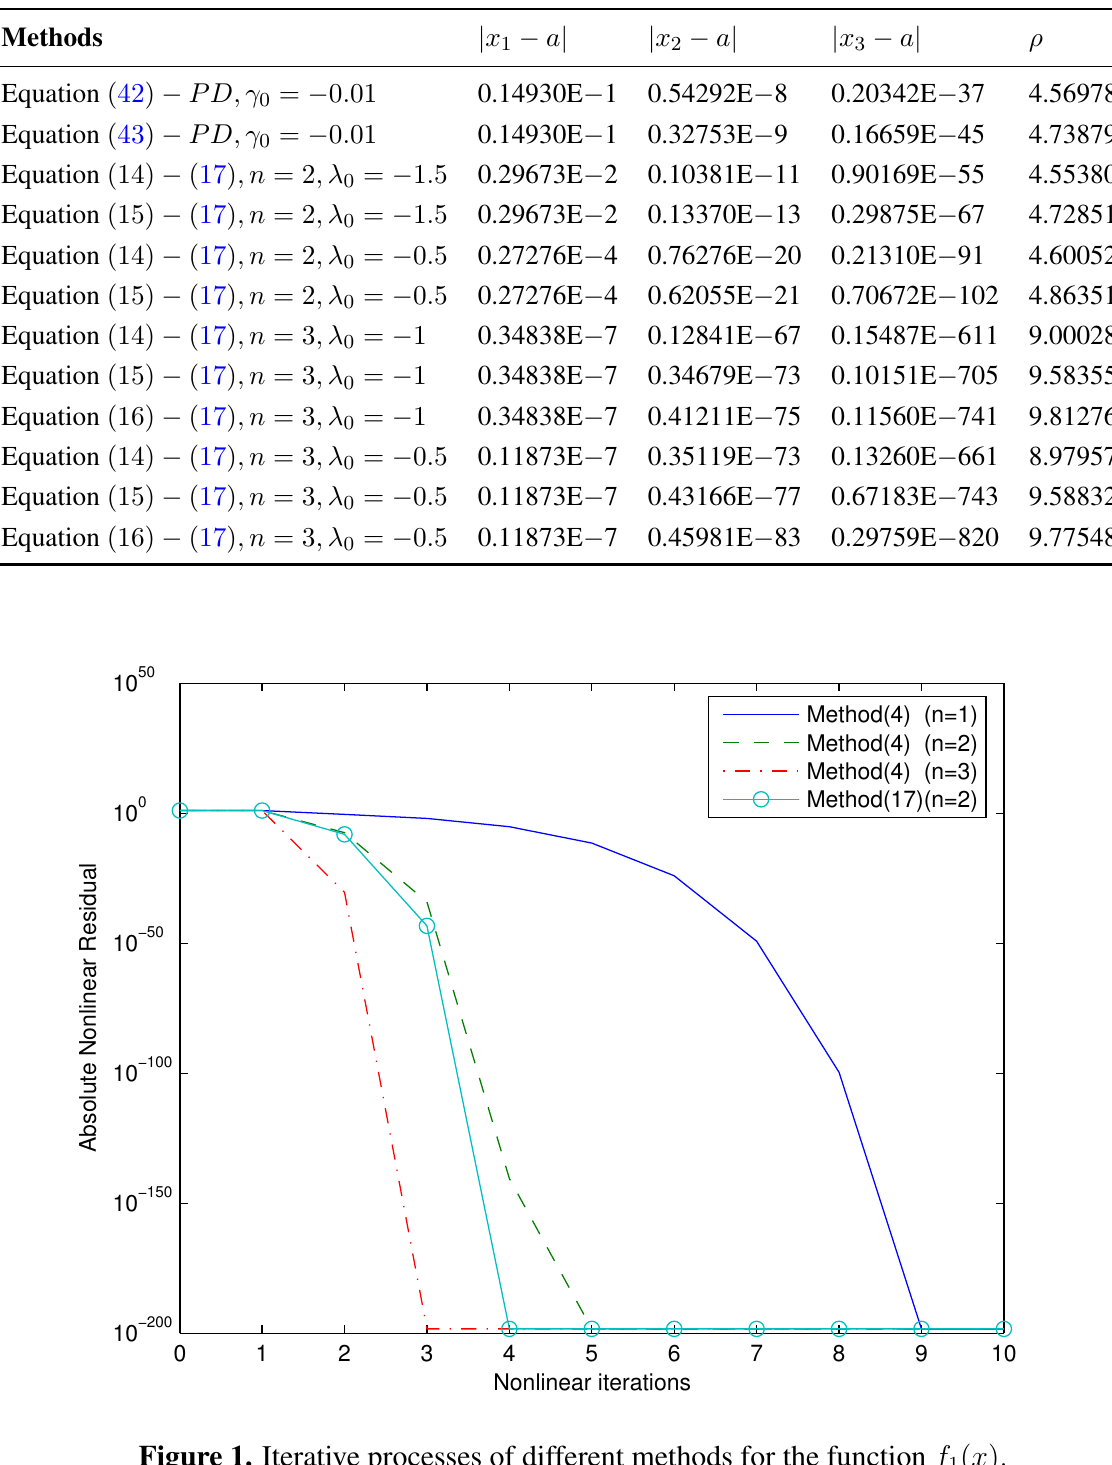
( x ) by the methods with memory. 2